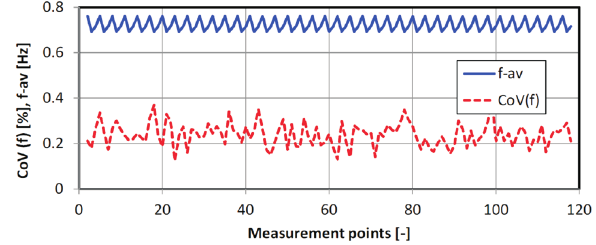
Fig. 6. Analysis of sampling frequency and its distributions